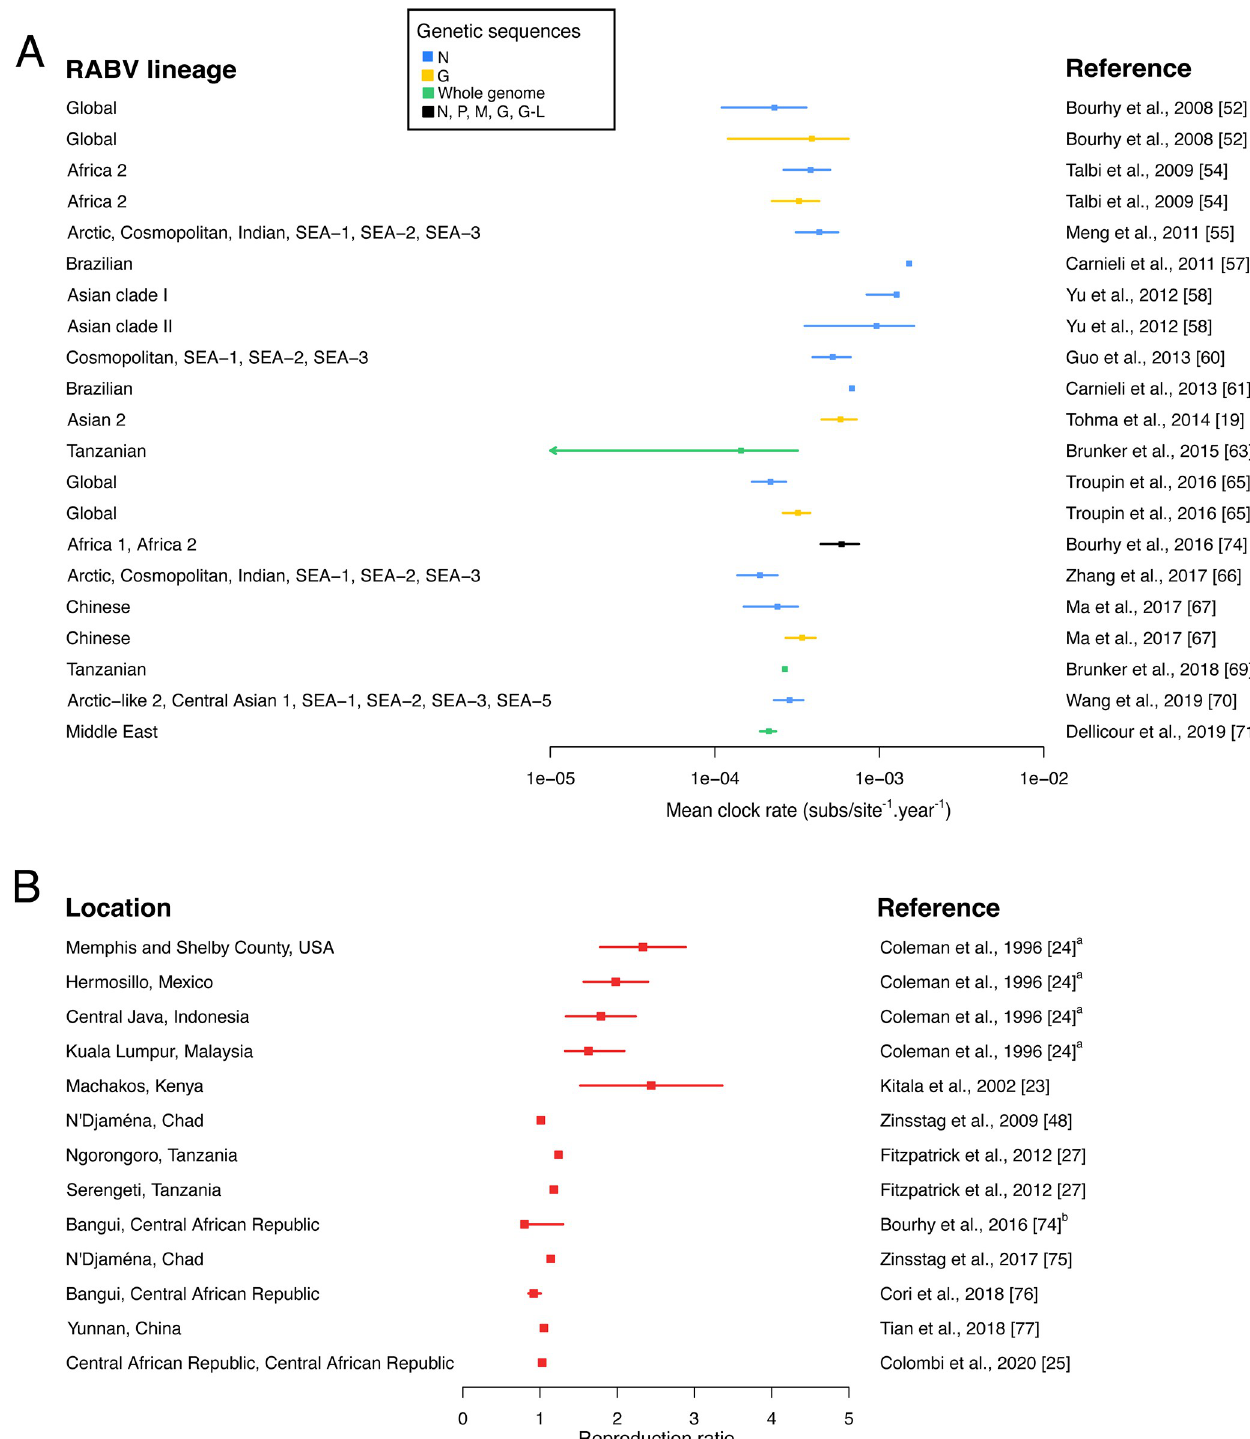
Fig 3. Estimates of the mean evolutionary rate of RABV and the reproduction ratio of canine rabies in the included studies. (A) Bayesian credibility intervals (mean and 95% Highest Posterior Density, HPD) of the mean evolutionary rate of canine RABV per genetic sequence and RABV lineage. aThe estimate corresponds to the upper bound of the 95% HPD. bThe dot corresponds to the median and the interval to the 95% HPD interval. cThe 95% HPD was not specified in the original publication. (B) Estimates of the reproduction ratio of dog rabies per control strategy or geographical location. The dot corresponds to the mean and the interval to the 95% confidence interval unless stated otherwise. a The interval corresponds to the standard error. b The authors estimated the effective reproduction ratio along time. Here, the value range of the median monthly point estimate is depicted.